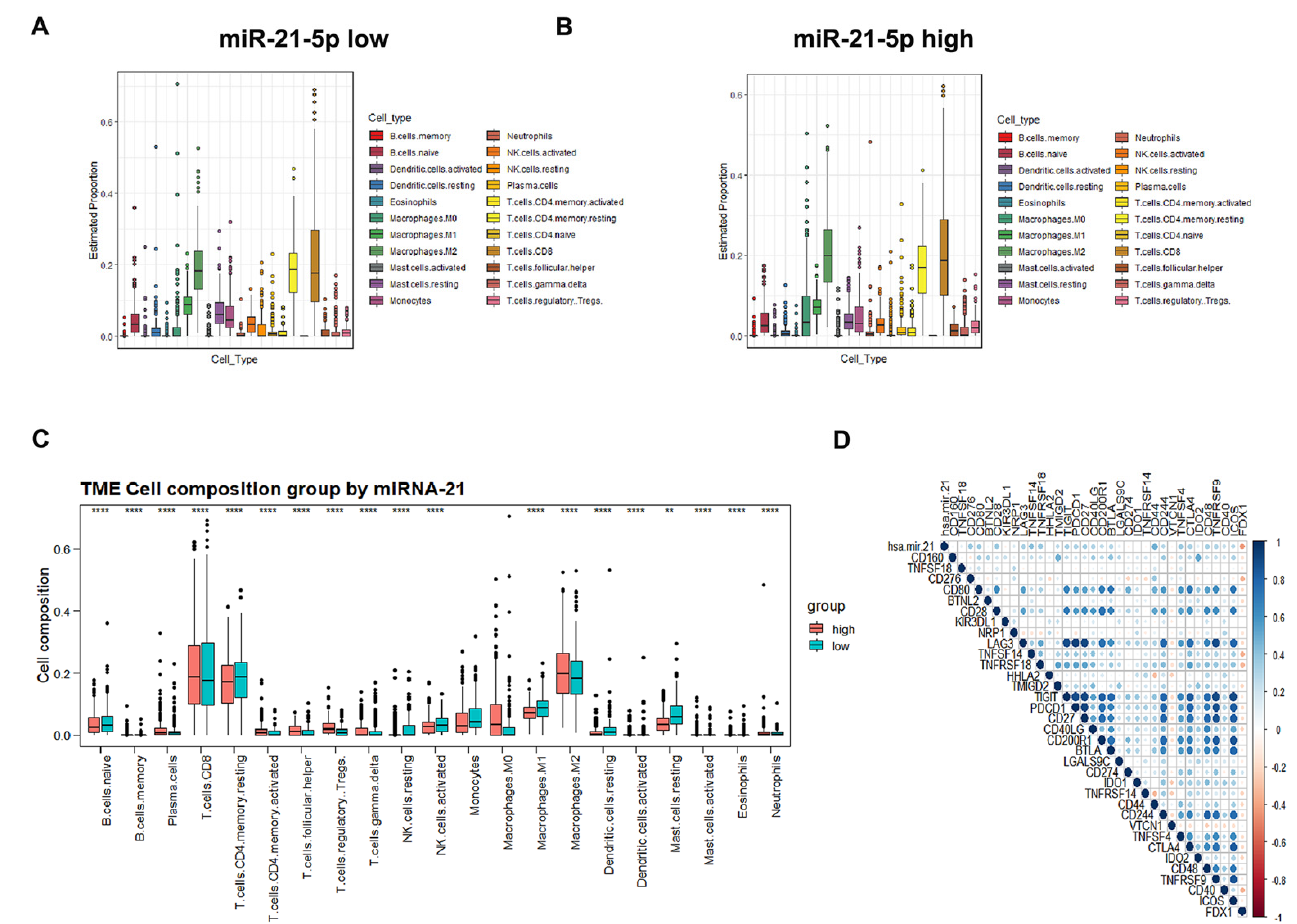
Figure 7. Immune cell infiltration and prognostic prediction model under the miR-21-5p/FDX1 axis. ( A ) Estimated proportion of tumor microenvironmental components in miR-21-5p_low ccRCC patients. ( B ) Estimated proportion of tumor microenvironmental components in miR-21-5p_high ccRCC. ( C ) Comparison of tumor microenvironmental components between miR-21-5p_high and miR-21-5p_low ccRCC. ( D ) Correlation of miR-21-5p/FDX1 with immune checkpoints. ** p < 0.01; **** p < 0.0001.